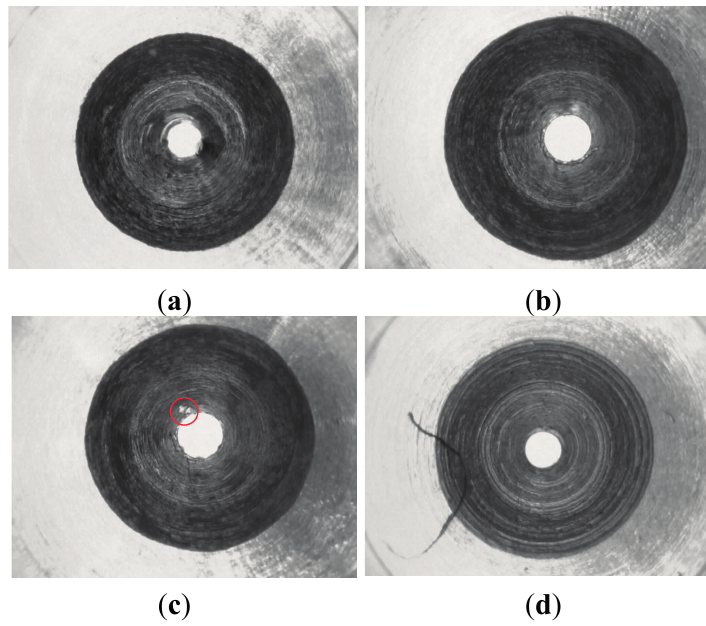
Figure 3. Four possible defects. ( a ) Small outlet; ( b ) Deckle edge of outlet; ( c ) Pellet metal fillings; ( d ) Strip metal fillings.